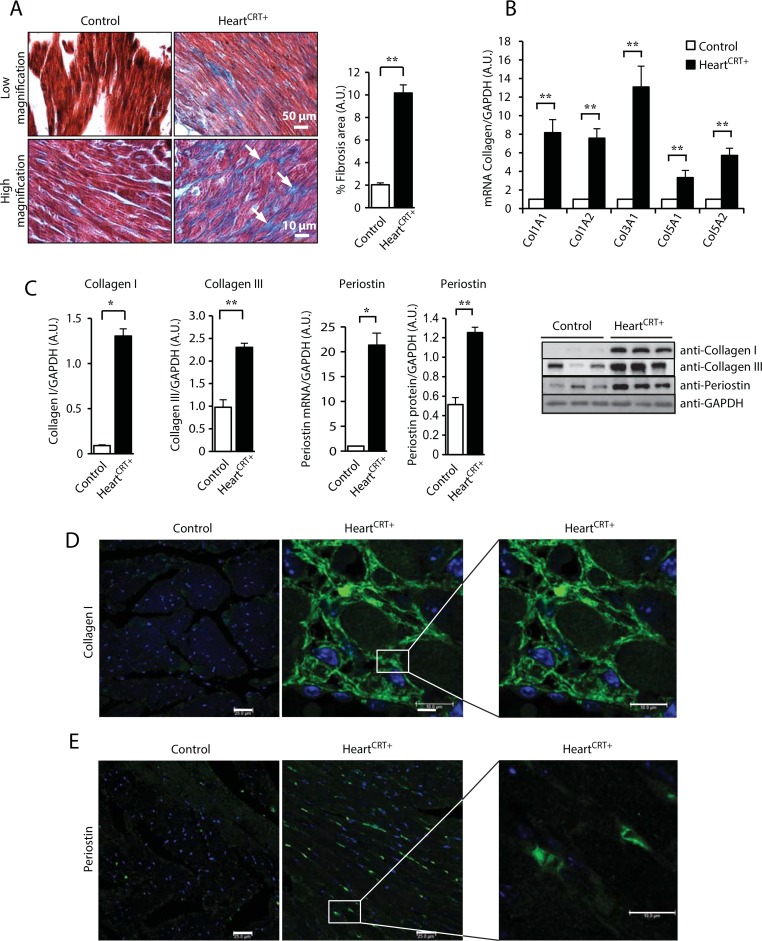
Fibrosis and increase abundance of collagen and periostin in heart with increased expression of calreticulin.(A) Gomori’s trichrome staining for collagen depositions in control and HeartCRT+ myocardium. The arrows indicate the location of the blue staining for collagen. Quantitative analysis of the percentage of areas with collagen deposition in control and HeartCRT+ hearts is shown to the right. **p<0.01. Data are representative of 6 biological replicates. (B) Abundance of fibrillar collagen mRNA was analyzed by Q-PCR. Values were normalized to glyceraldehyde 3-phosphate dehydrogenase (GAPDH) mRNA. Col1A1, collagen type I, alpha 1; Col1A2, collagen type I, α2; Col3A1, collagen type III, α1; Col5A1, collagen type V, α1; Col5A2, collagen type V, α2. ** p<0.01. Data are representative of 9 biological replicates. (C) Immunoblot analysis and quantification of the abundance of collagen type I in control and HeartCRT+ hearts. Anti-GAPDH were used as a loading control. **p<0.01. Data are representative of 6 biological replicates. (D) Abundance of collagen type III in control and HeartCRT+ hearts. Anti-GAPDH antibodies were used as a loading control. *P<0.05. Data are representative of 6 biological replicates. (E) Subcellular distribution of type I collagen by immunohistochemistry in cardiac tissue cross-sections from control and HeartCRT+ hearts. Green color represents staining for type I collagen. (F) Abundance of periostin mRNA in control and HeartCRT+ hearts. **p<0.01. Data are representative of 9 biological replicates. Immnoblot and quantitative analyses of periostin in HeartCRT+ and control transgenic hearts. *p<0.05. Anti-GAPDH antibodies were used as a loading control. Data are representative of 6 biological replicates. (G) Cellular distribution of periostin in cardiac tissue cross-sections from control and HeartCRT+ hearts. Nuclei were visualized with DAPI staining. 3–5 animals were used for each analysis.